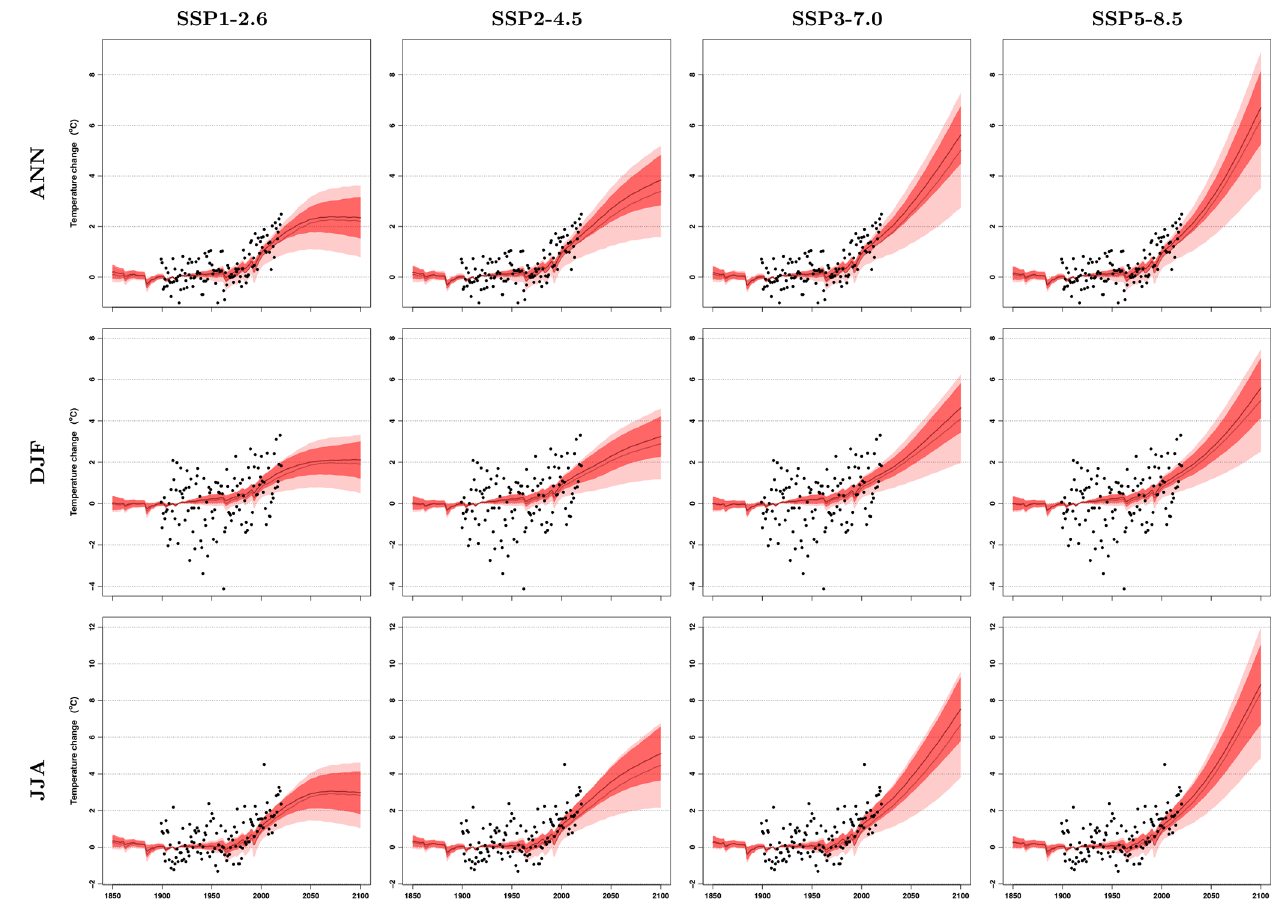
Figure 5. Constrained mean temperature projections. CMIP6 projections constrained by both global (GSAT) and regional observations for annual, winter, and summer mean temperature over France and for the four illustrative SSP scenarios considered in this study. Annual mean temperatures over France (black points) are compared to the unconstrained (pink) and constrained (red) 5% to 95% confidence ranges of the forced response, as estimated from CMIP6 models. All temperatures are anomalies with respect to the period